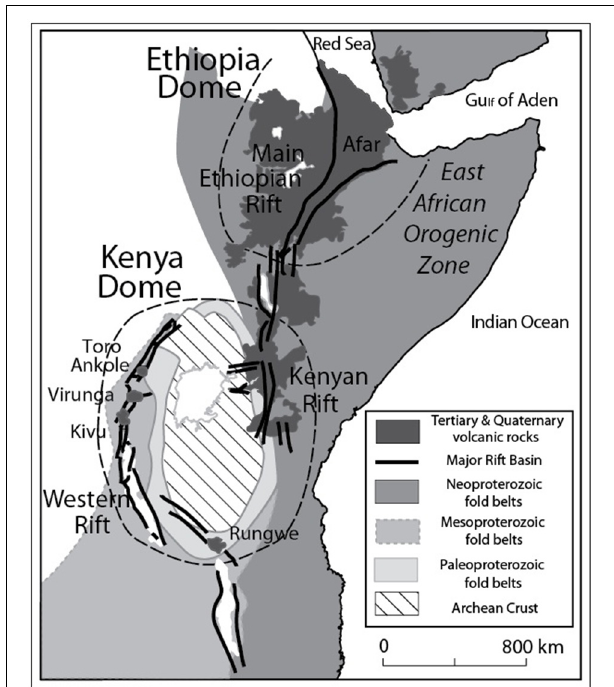
FIGURE 1 | Sketch map of East Africa showing the locations of the Main Ethiopia, Kenyan and Western rifts, the distribution of Tertiary—Recent volcanism and disposition of basement of contrasting ages. Curved dash lines denote the extent of the Ethiopia and Kenyan domes and dark lines mark the strike of the major border faults of the main rift valleys (modified after Begg et al.,